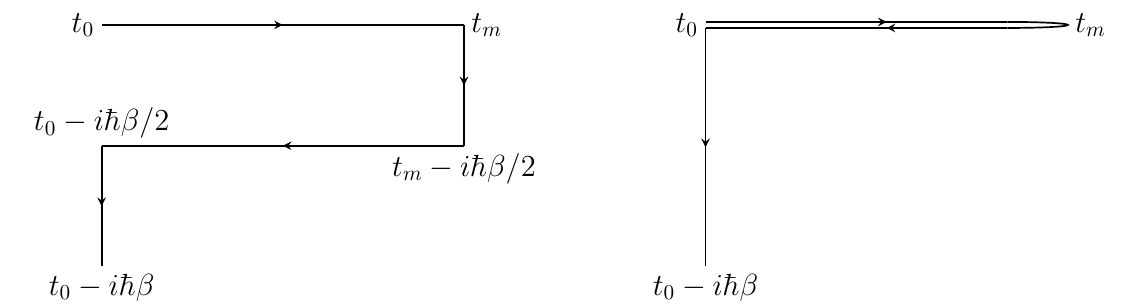
Figure 2 . For thermal equilibrium, the complex time path is periodic along the imaginary time direction, with the period ~ (cid:12) , and there is some freedom in choosing the contour in the complex time plane. (L) The Schwinger-Keldysh closed time contour used in [2, 3]; (R) The Schwinger- Keldysh closed time contour used in [8]. In section 3.3 we use the right-hand side path to derive analytic expressions, where both trajectories of t 0 ! t m and t m ! t 0 are located on the real-time line, and the vertical o(cid:11)set between them exists only for demonstration